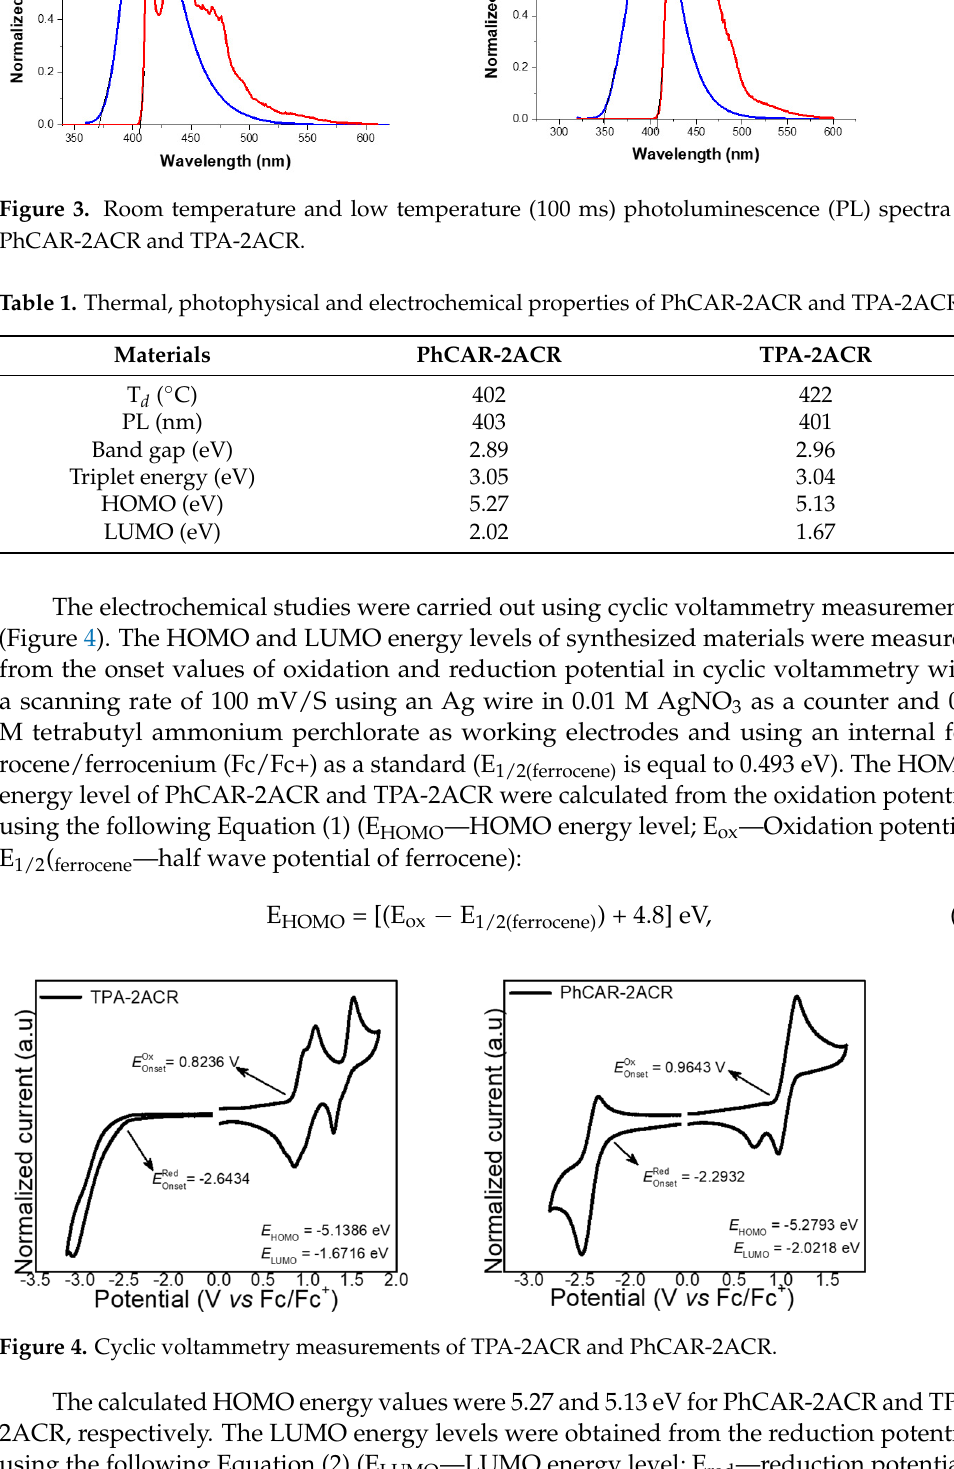
Figure 5. Device energy diagram and device structure of phosphorescent OLEDs. The current efficiency of TAPC, PhCAR ‐ 2ACR and TPA ‐ 2ACR ‐ based yellow phos ‐ phorescent OLEDs were 32.53, 23.13 and 55.74 cd/A, respectively (Figure S1 and S2 and Table 2). The power efficiencies were 18.58, 6.05 and 29.28 lm/W for TAPC, PhCAR ‐ 2ACR and TPA ‐ 2ACR, respectively. Triphenylamine ‐ based TPA ‐ 2ACR showed excellent cur ‐ rent and power efficiencies when compared to reference TAPC and carbazole ‐ based PhCAR ‐ 2ACR. The external quantum efficiencies (EQEs) of TAPC, PhCAR ‐ 2ACR and TPA ‐ 2ACR based devices were recorded as 10.6, 7.65 and 21.59%, respectively. Triphenyl ‐ amine ‐ based TPA ‐ 2ACR revealed two ‐ time higher EQE than reference TAPC ‐ based sim ‐ ilar device. Since carbazole is a weak donor, PhCAR ‐ 2ACR showed comparatively lower device efficiencies. Moreover, triphenylamine has a strong electron ‐ donating moiety when compared to carbazole moiety, so better device performance of TPA ‐ 2ACR can be attributed to its superior hole ‐ transporting ability. To investigate the properties of synthesized materials further as a host application, we have fabricated another set of yellow phosphorescent OLEDs using PhCAR ‐ 2ACR and TPA ‐ 2ACR as hole ‐ transporting (HT) ‐ type host materials. CBP host material was used as the reference HT ‐ type host material for our current study. The current efficiencies of CBP, PhCAR ‐ 2ACR and TPA ‐ 2ACR were 47.83, 56.90 and 53.15 cd/A and power efficiencies were 42.94, 35.75 and 41.74 lm/W, respectively (Figure 6). The maximum EQEs of CBP, PhCAR ‐ 2ACR and TPA ‐ 2ACR ‐ based devices were 18.16, 20.57 and 17.20%, respectively.